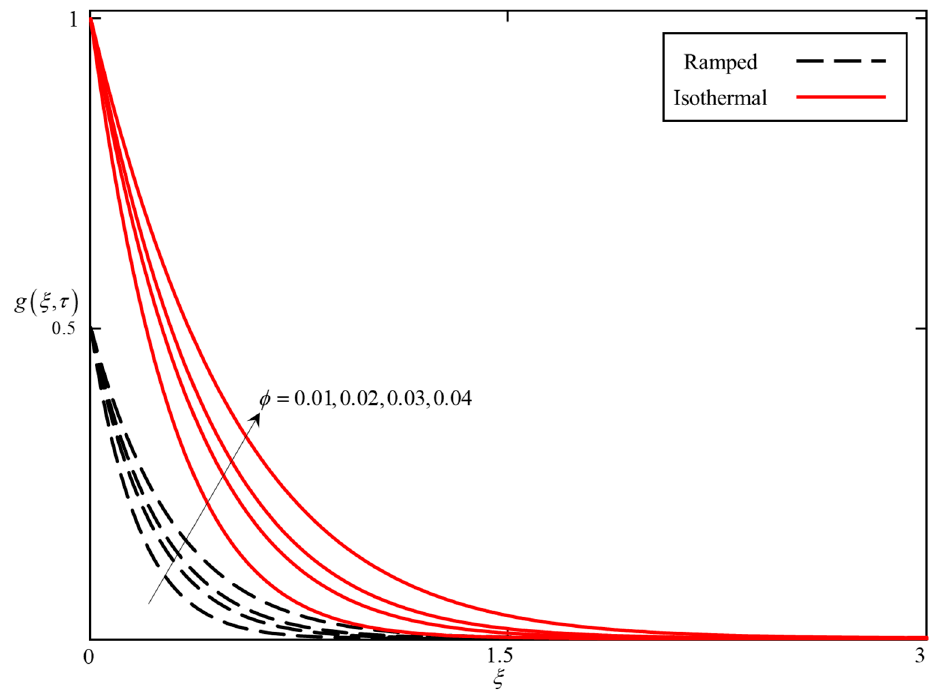
Figure 8. Consequence of φ on the temperature field when α = 0.5 and Pr = 21